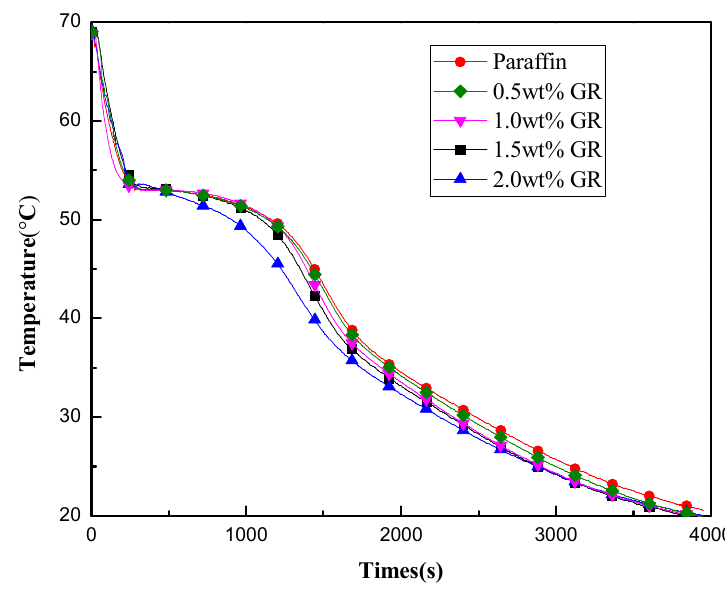
Figure 8. Melting Curves of GR/Paraffin CPCM with Different Concentrations.